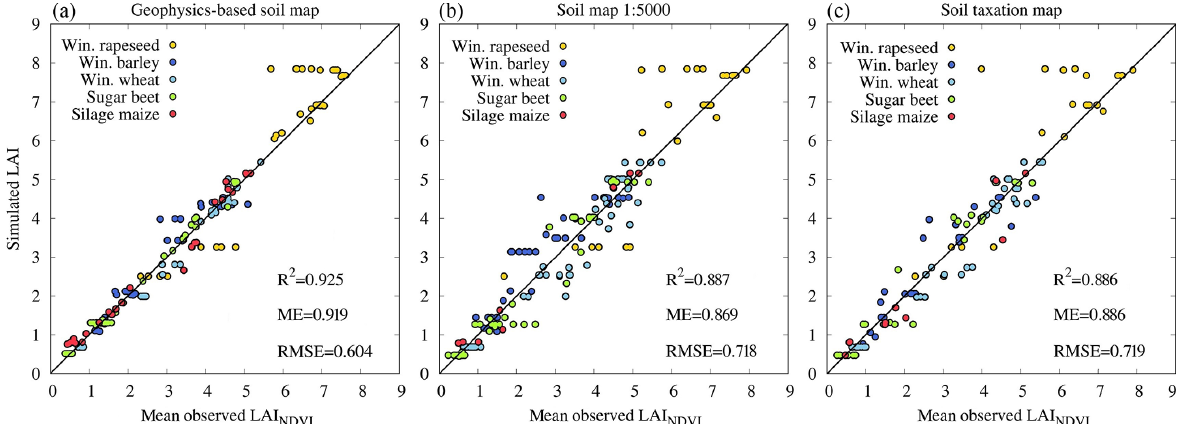
Figure 6. Simulated LAI and mean observed LAI NDVI for each soil–crop combination for simulations based on (a) the geophysics-based soil map, (b) the 1:5000 soil map, and (c) the soil taxation map for all six available RapidEye images.